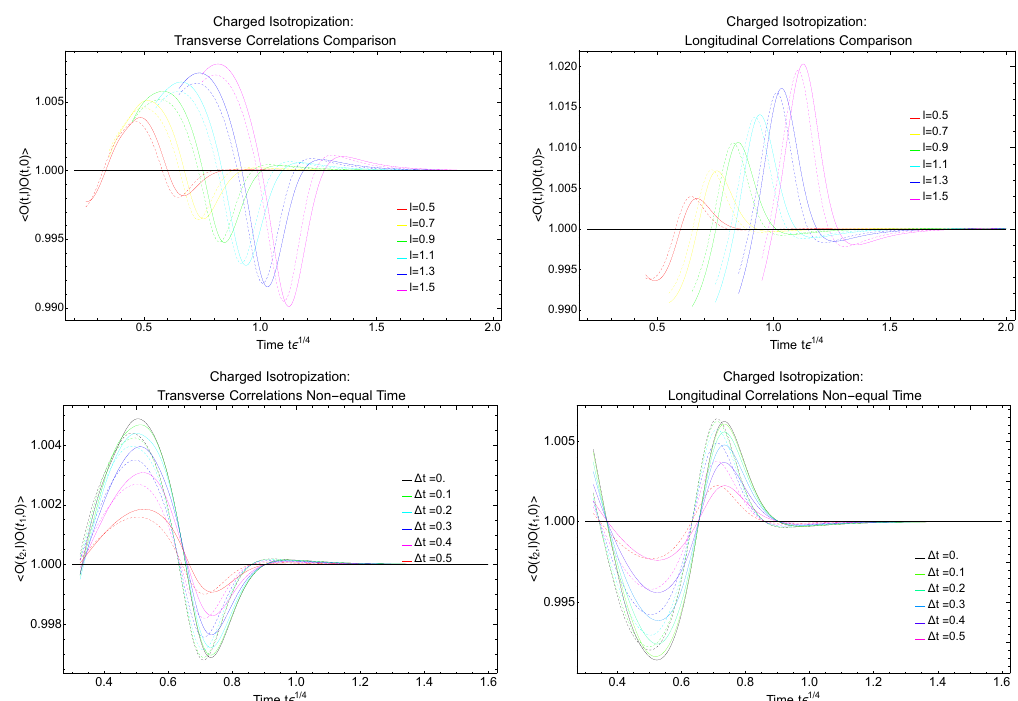
Figure 11 . 2-point correlation functions for (uncharged) scalar operator in a charged thermalizing (cid:13)uid (RN black brane geometry), (cid:26) = 0 : 78 (cid:26) e ; B = 0, case (b) in (cid:12)gure 1. Top Left: various length separations in the transverse direction at (cid:1) t = 0. Top right: various length separations in the longitudinal direction at (cid:1) t = 0. Bottom left: various time separations (cid:1) t , (cid:12)xed transverse length separation l = 0 : 65. Bottom Right: various time separations (cid:1) t , (cid:12)xed longitudinal length separation (cid:1) l = 0 : 65. In all plots dashed lines are calculated in the neutral anisotropic case (a) shown for comparison, and solid lines correspond to the charged anisotropic case (b).